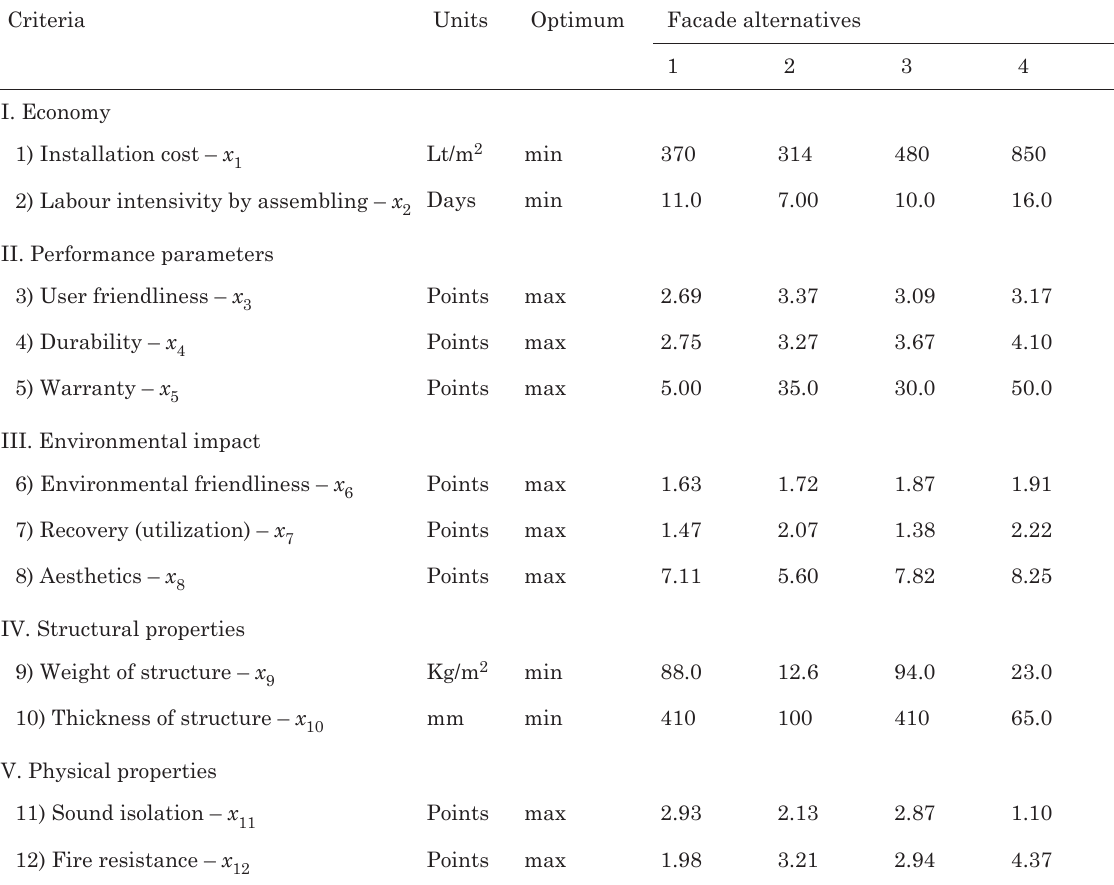
table 1. Criterion system for comparison of façade alternatives